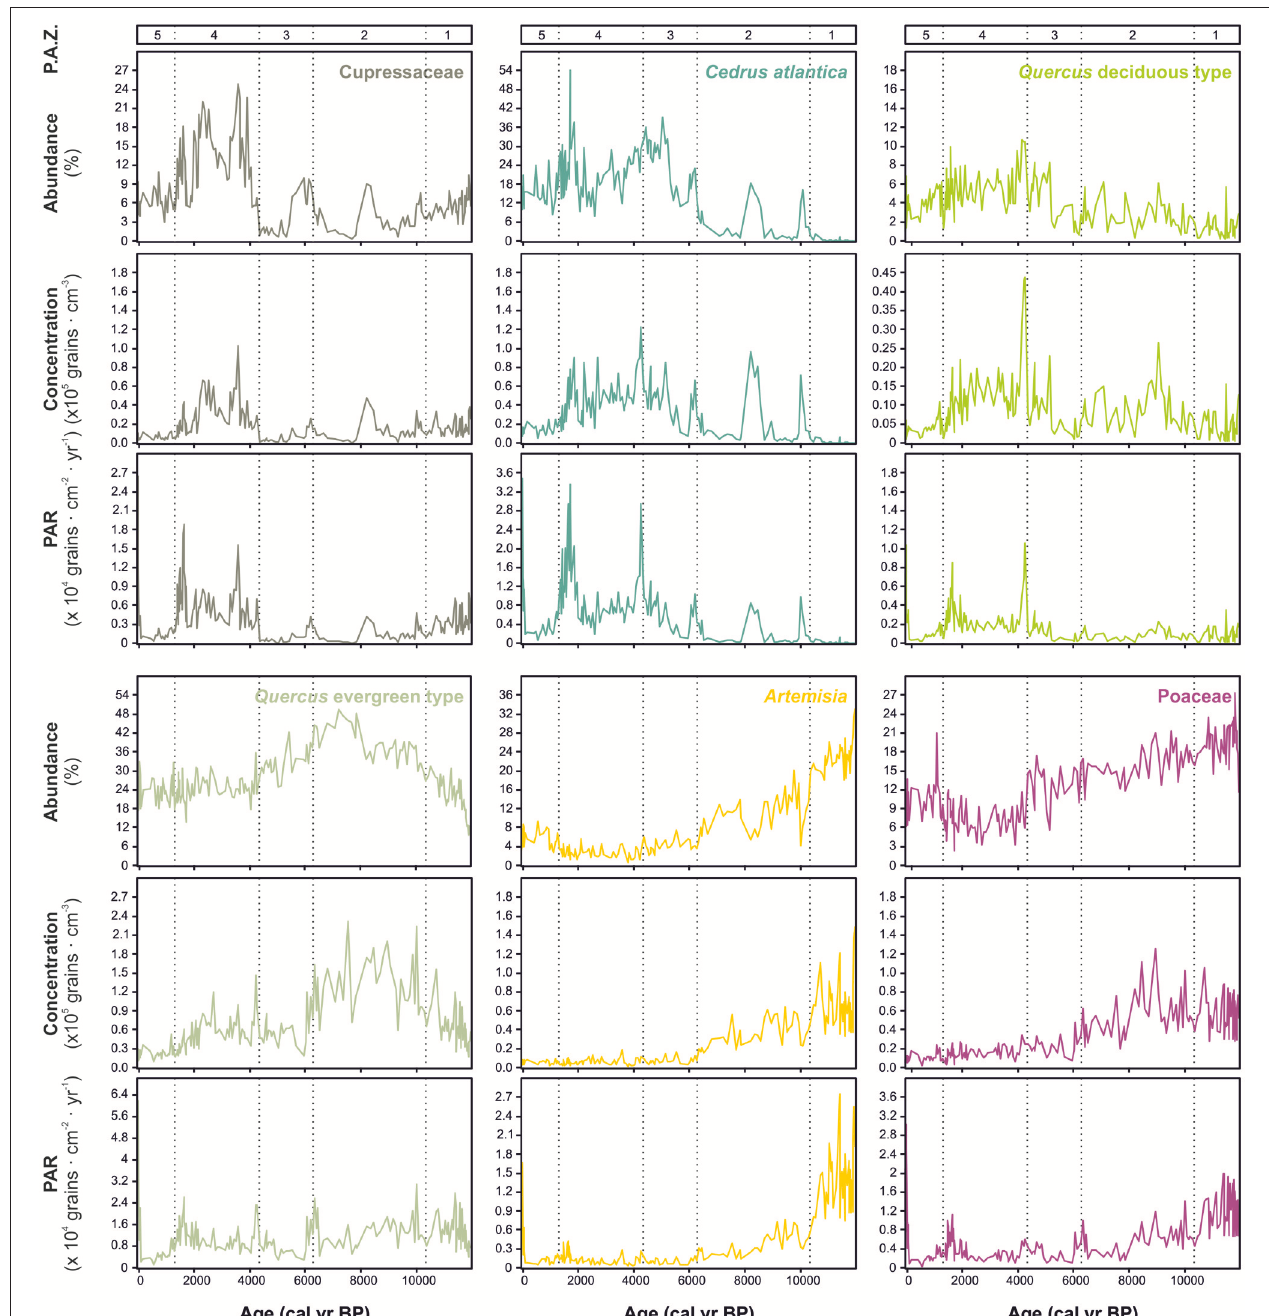
FIGURE 7 | Comparison of percentage, concentration and pollen accumulation rate (PAR) values for six main taxa at Lake Sidi Ali plotted against age with pollen assemblage zones (PAZs) indicated.